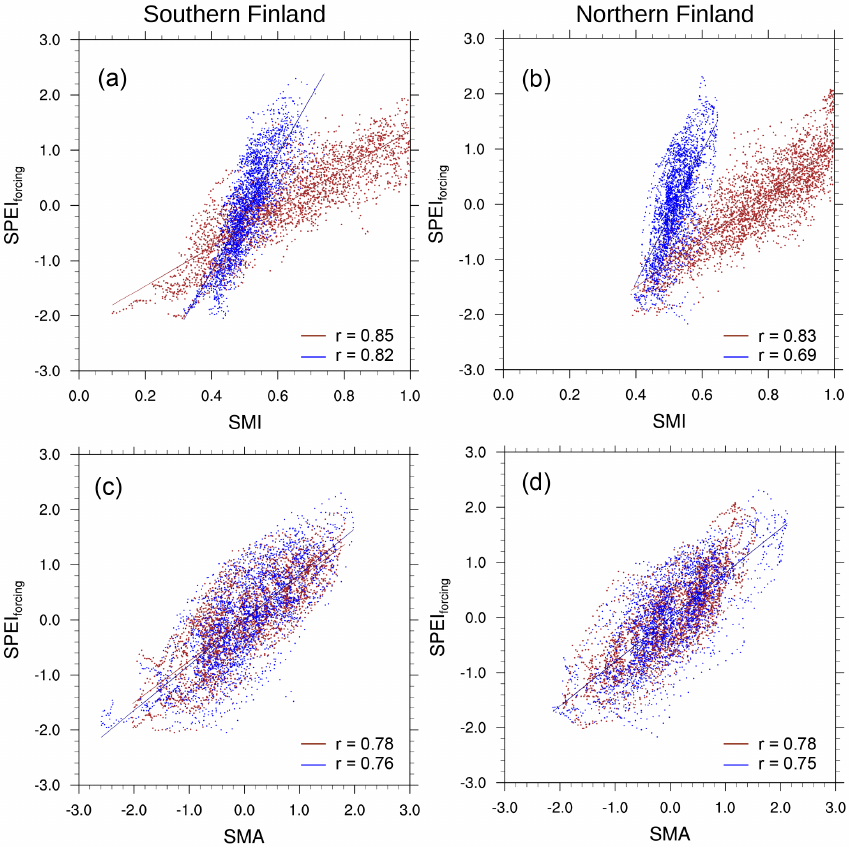
Figure 5. Time correlations over the study period between SPEI forcing and SMI (a, b) , SPEI forcing and SMA (c, d) with the spatial means over the mineral soil areas (brown) and the peat soil areas (blue) in southern Finland (left column panels) and northern Finland (right column panels), respectively.